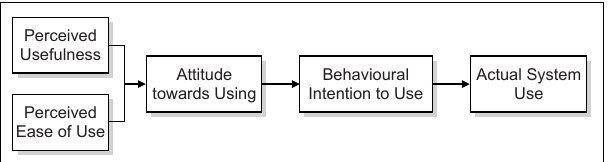
FIGURE 1: Technology acceptance model.